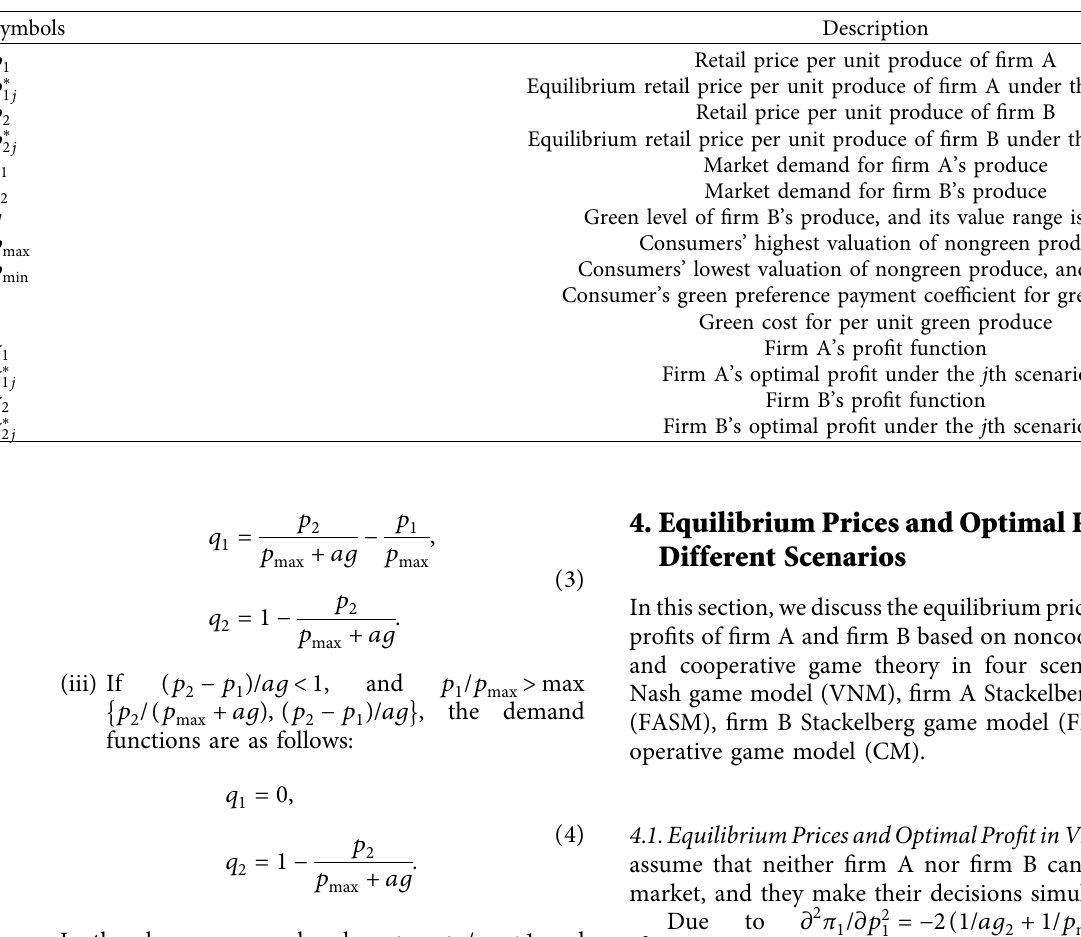
Table 1: Parameter symbols and